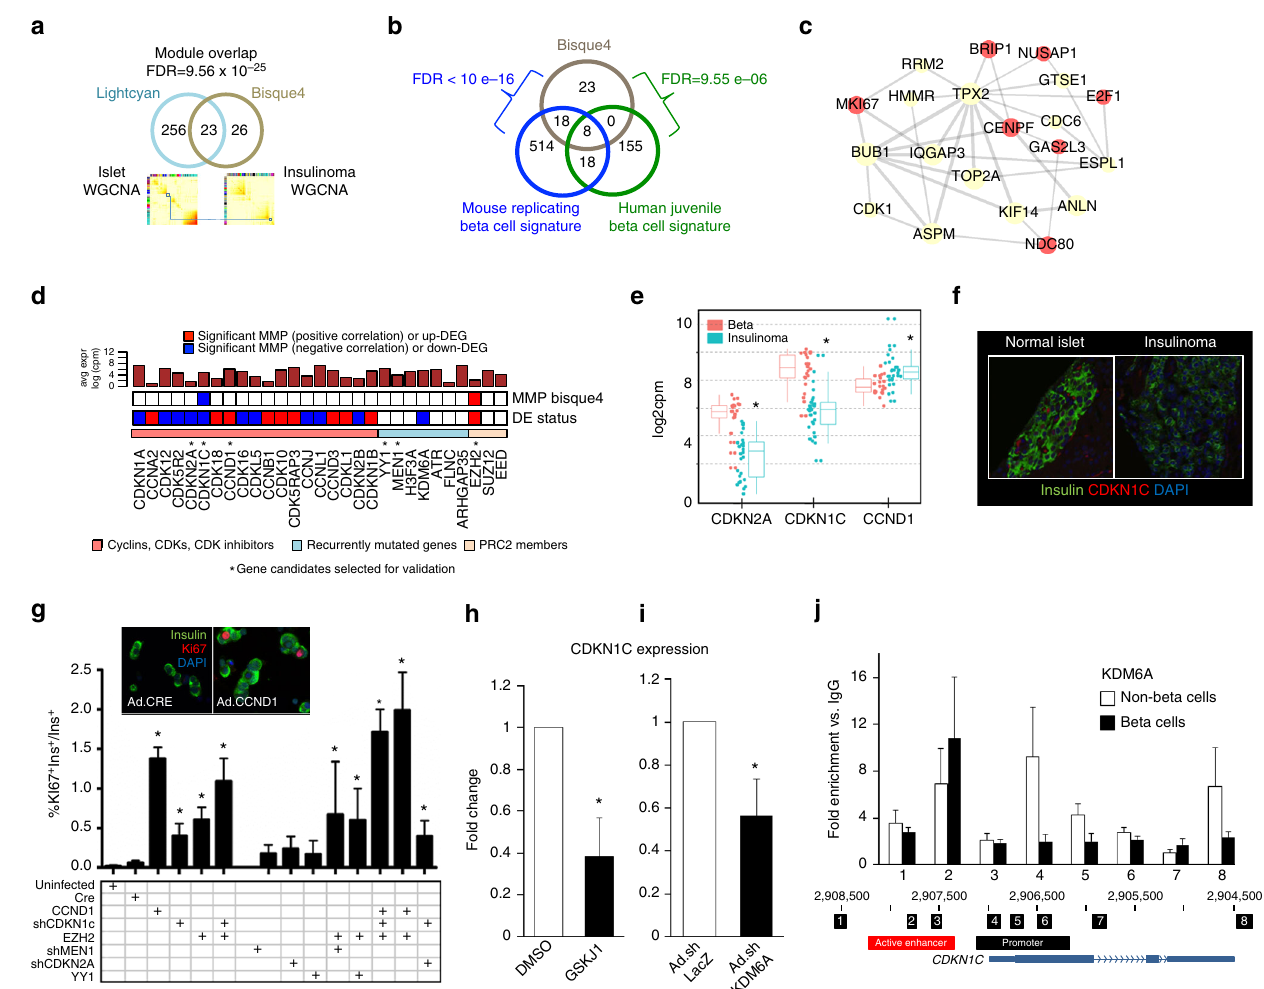
Fig. 5 Comparison of the bisque4 insulinoma proliferation module with adult human islets, replicating normal human juvenile and mouse beta cells, validation of gene candidates for beta cell proliferation, and direct modulation of CDKN1C by trithorax member, KDM6A. a The insulinoma proliferative bisque4 module is preserved in the islet co-expression network. b The bisque4 module is the only signi fi cantly over-enriched module (at FDR = 0.01) via projection of gene signatures of human juvenile beta cells and from replicating mouse beta cells onto insulinoma co-expression network. c The top 20 “ hub genes ” in the bisque4 module based on intra-modular connectivity. Red balls indicate differentially upregulated genes (FDR < 0.01); yellow balls , non- signi fi cant. Increased line weights indicate stronger connectivity. d A panel of predicted candidate genes as possible mediators of beta cell proliferation. The top bar graph shows their level of average expression based on RNAseq (log2CPM). The fi rst row shows their bisque4 MMP status; the second row shows their DE status in insulinomas vs. beta cells. Genes selected for validation are marked with an asterisk . e Differential expression from RNAseq for CDKN2A, CDKN1C , and CCND1 in insulinomas vs. beta cells. f A representative immunohistochemical photomicrograph showing p57 KIP2 ( red ) is readily detectable in approximately half of beta cell ( green ) nuclei, but undetectable in non-beta cell islet cell types and insulinomas. g Induction of proliferation in human beta cells by adenoviral overexpression or silencing of the genes shown. Each bar represents the mean of 4 – 10 different human islet preparations. Error bars indicate mean ± SEM; asterisks indicate p < 0.05 by Student ’ s t -test. Note that expression of CCND1 or EZH2 , or silencing of CDKN1C individually all induce human beta cells to enter cell cycle at rates comparable to those observed in insulinomas, and that EZH2 - shCDKN1C combination appears additive. In contrast, silencing MEN1 , or overexpressing wild-type or mutant YY1 fails to activate proliferation under the conditions studied. Asterisks indicate p < 0.05 by Student ’ s t -test. The inset shows examples of Ki67 immunolabeling ( red ) in human beta cells ( green ) induced by a control adenovirus encoding Cre recombinase and adenoviruses encoding CCND1 . Similar effects were seen with EZH2 or shCDKN1C (not shown). h Repression of CDKN1C expression in human islets by the KDM6A inhibitor, GSKJ1. Error bars indicate mean ± SEM of fi ve human islet preps; asterisks indicate p < 0.05 by Student ’ s t -test. i Repression of CDKN1C expression by adenoviral silencing of KDM6A in human islets. Error bars indicate mean ± SEM of fi ve human islet preps; asterisks indicate p < 0.05 by Student ’ s t -test. j Top panel: ChIP analysis of KDM6A binding to the CDKN1C locus in fi ve pairs of FACS-sorted human beta cells and non-beta cells. Error bars indicate mean ± SEM. Bottom panel: A genome browser view of the CDKN1C locus highlighting primer pairs 1 – 8 43 , promoters, enhancers, exons, and transcriptional start site of CDKN1C . In beta cells, KDM6A binds to CDKN1C , predominantly at an upstream enhancer delineated by primer pair #2. KDM6A also binds to CDKN1C in non-beta cells of the islet. Note that the directionality of this panel is opposite that in Fig.